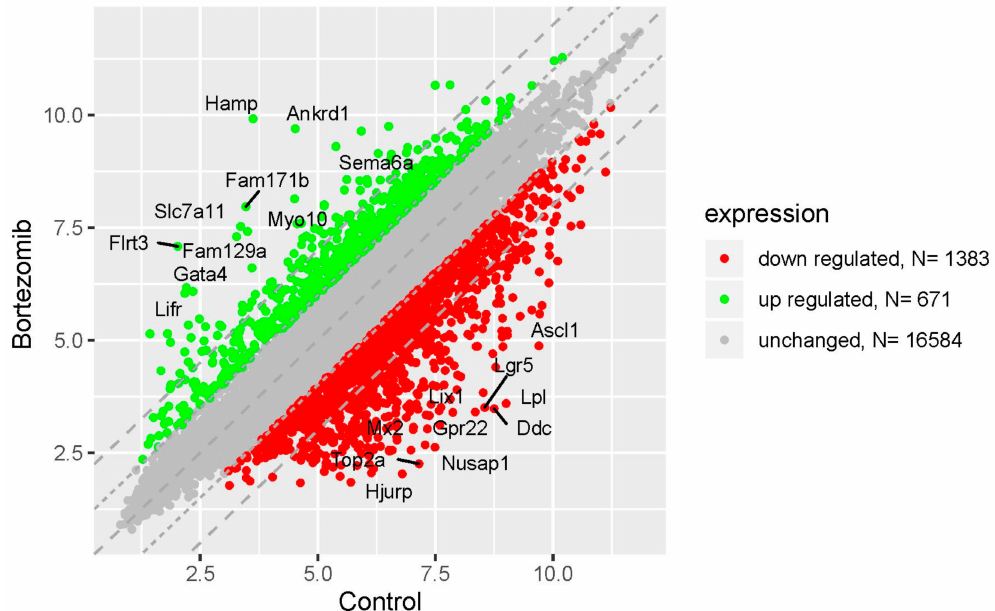
Figure 1. The scatter plot of global gene expression in bortezomib-treated PC12-derived nerve cells compared to the control cells. Genes are represented by dots (red colour: Downregulation; green colour: Upregulation). The graph shows the genes with at least twofold change and p < 0.05. The graph also contains the symbol of the genes with the largest change in expression.